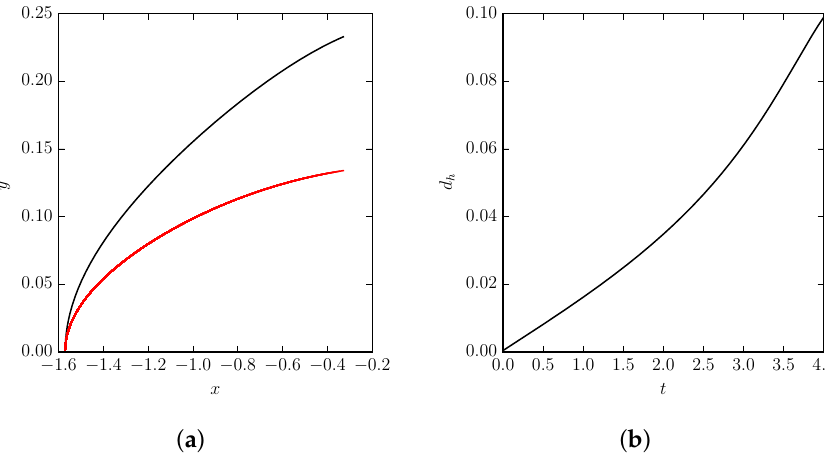
Figure 3. ( a ) trajectories of two point vortices with κ 1 = by the simplified model for a fixed filament with b ∗ m = 1 and a = 0.25. Vortex 1 is shown by the black curve while vortex 2 is shown by the red curve; ( b ) horizontal distance d h between the vortices versus time t